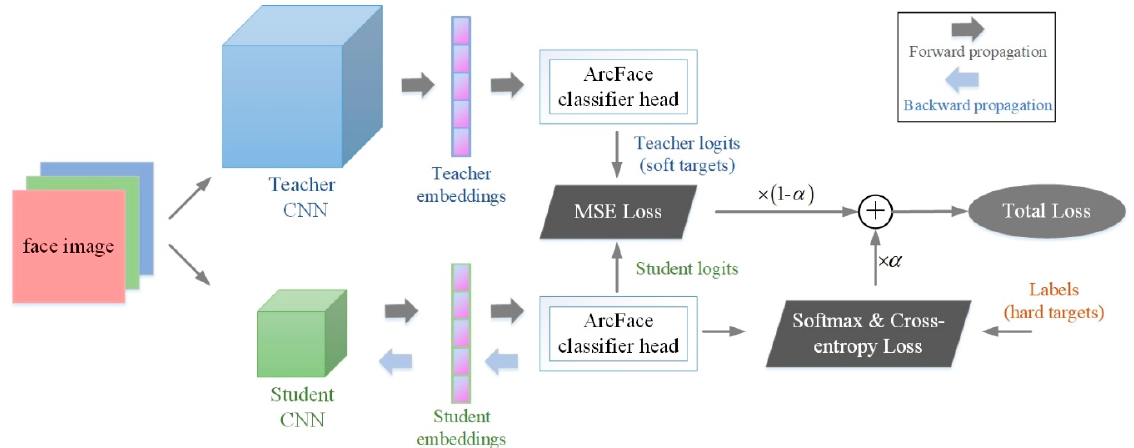
Figure 4. Workflow of the proposed teacher–student training method. Firstly, face images are input to the deep teacher network and the lightweight student network, separately, and the related embedding after feature extraction is obtained. Then, the embedding is input into the ArcFace classifier head with the additive angle margin, and the logits are obtained. We compute the MSE between the soft targets and the logits of the student network, and compute the softmax loss between the hard targets and the student logits. The weighted average of soft and hard loss functions is the final loss, and forms the basis of the back propagation of the gradients and the parameter update of the student network.